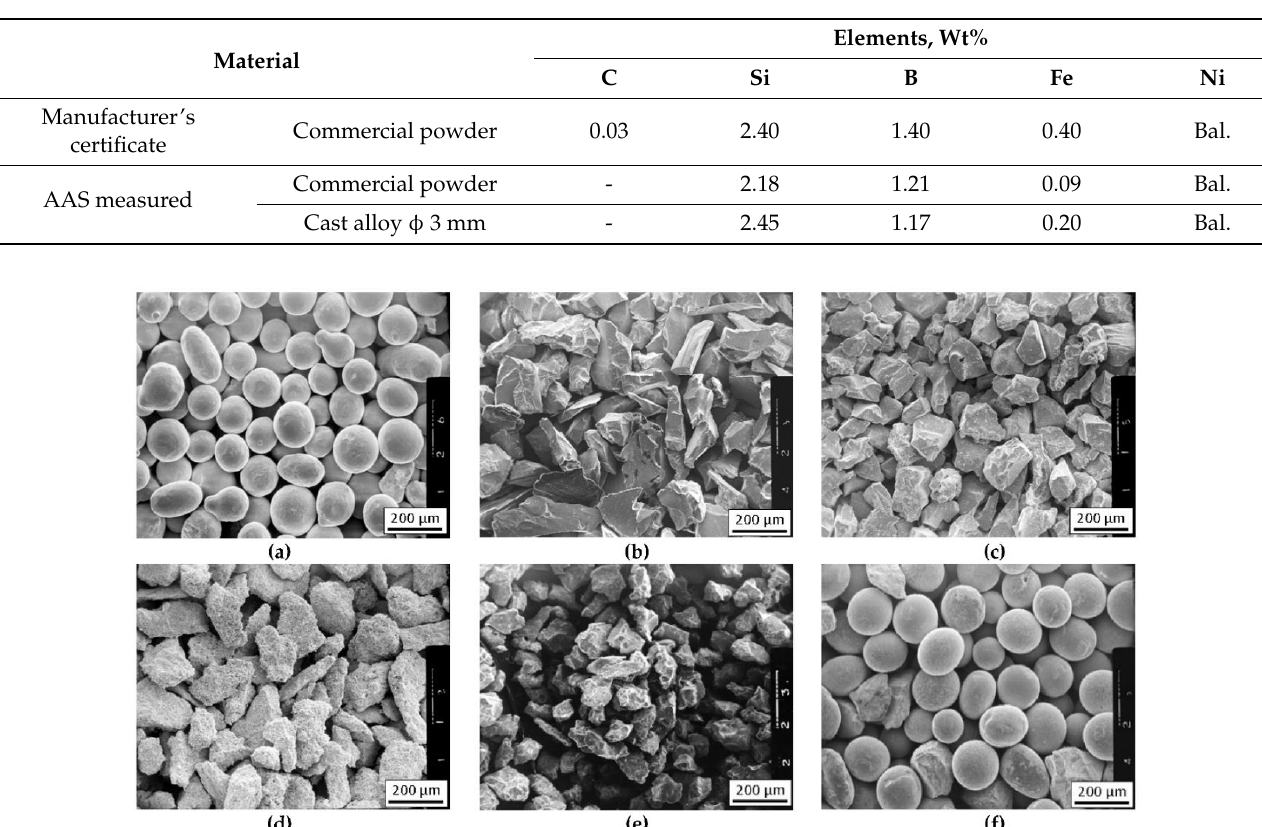
Table 1. The chemical compositions of NiBSi matrix materials used.